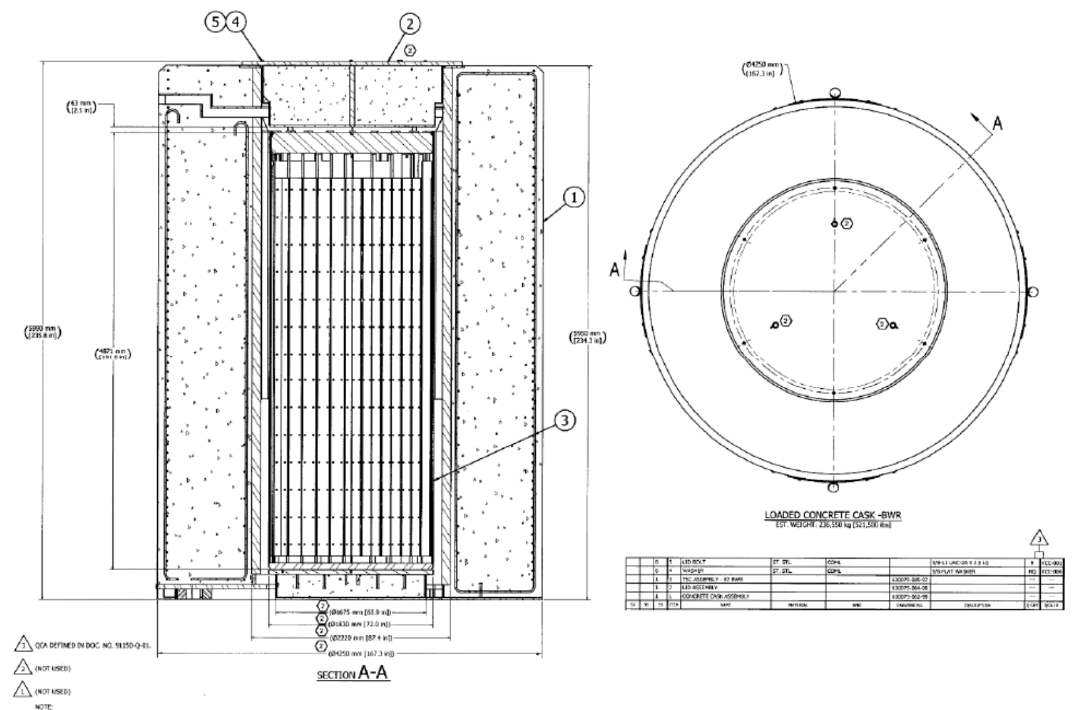
Figure 1. Design diagram of a dry storage cask.